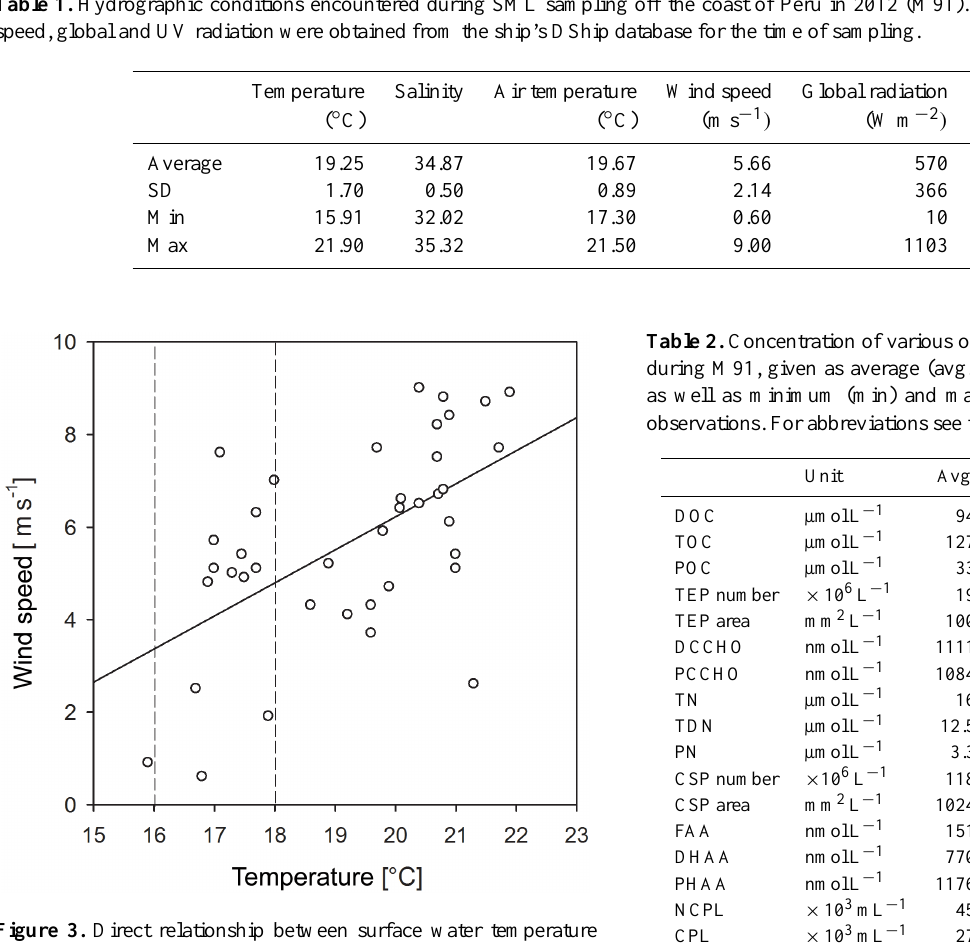
Figure 3. Direct relationship between surface water temperature and wind speed during M91 SML sampling, p <0.001, r = 0.58, n = 37. Data between 16 and 18 ◦ were selected for analysis of wind speed effects at similar temperatures, see Fig. 7.